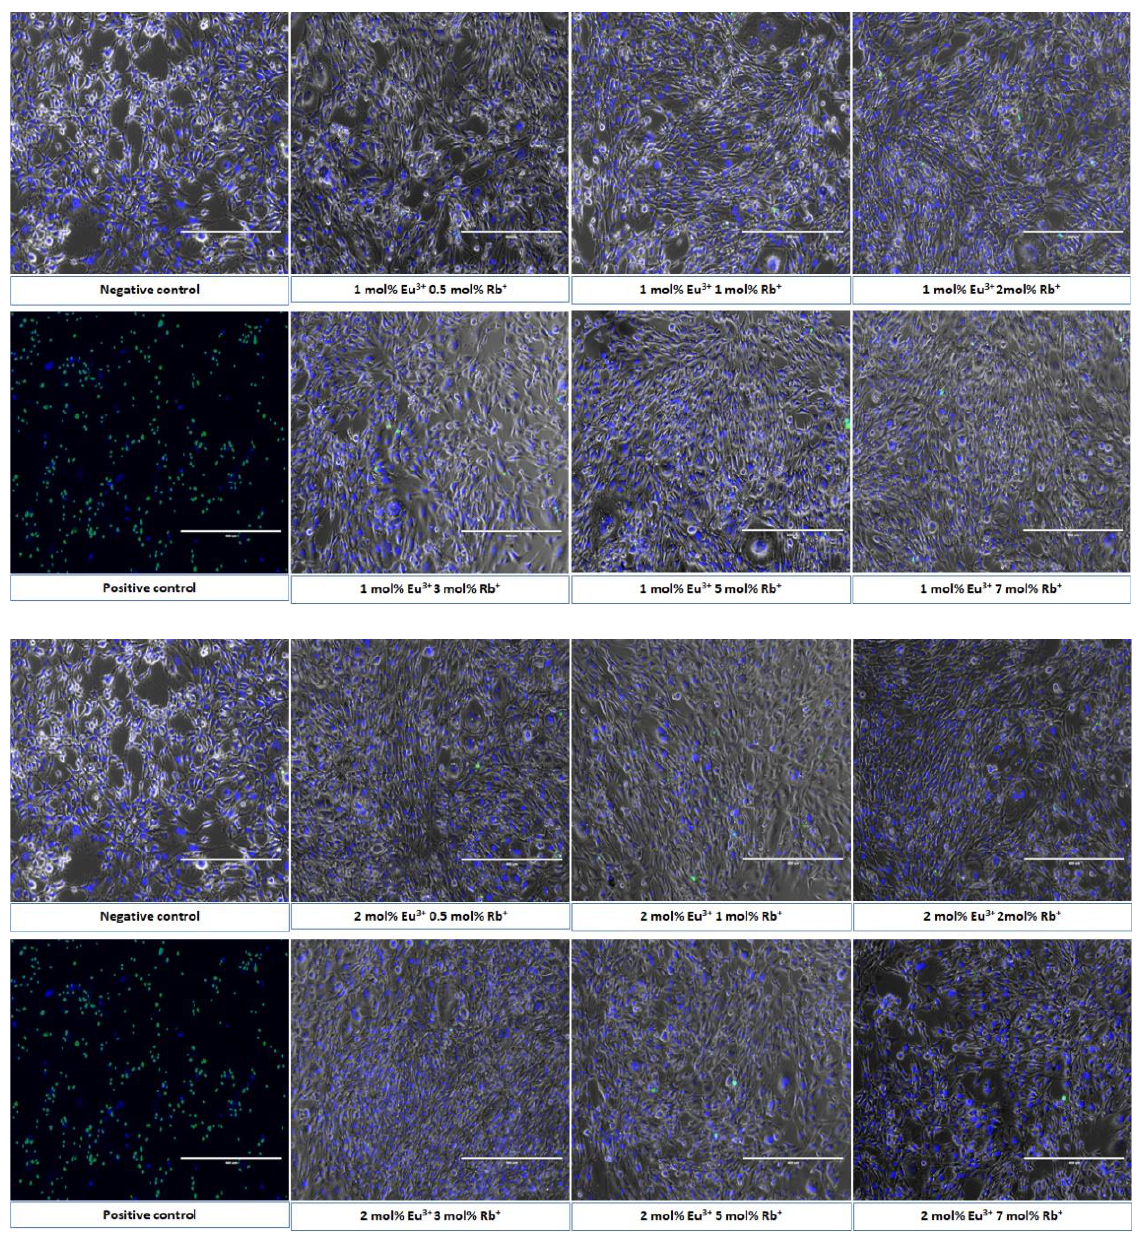
Figure 10. Mouse osteoblasts morphology after 24 h of incubation with both series of compounds Ca 10 − (0.1 + x) Eu 0.1 Rb x (PO 4 ) 6 (OH) 2 and Ca 10 − (0.2 + x) Eu 0.2 Rb x (PO 4 ) 6 (OH) 2 , where x = 0.5; 1; 2; 3; 5; 7 mol%) at the final concentration 100 µg/mL. The morphology was compared with negative control (PBS buffer) and positive control (1% H 2 O 2 ). Scale bar equals 400 µm.